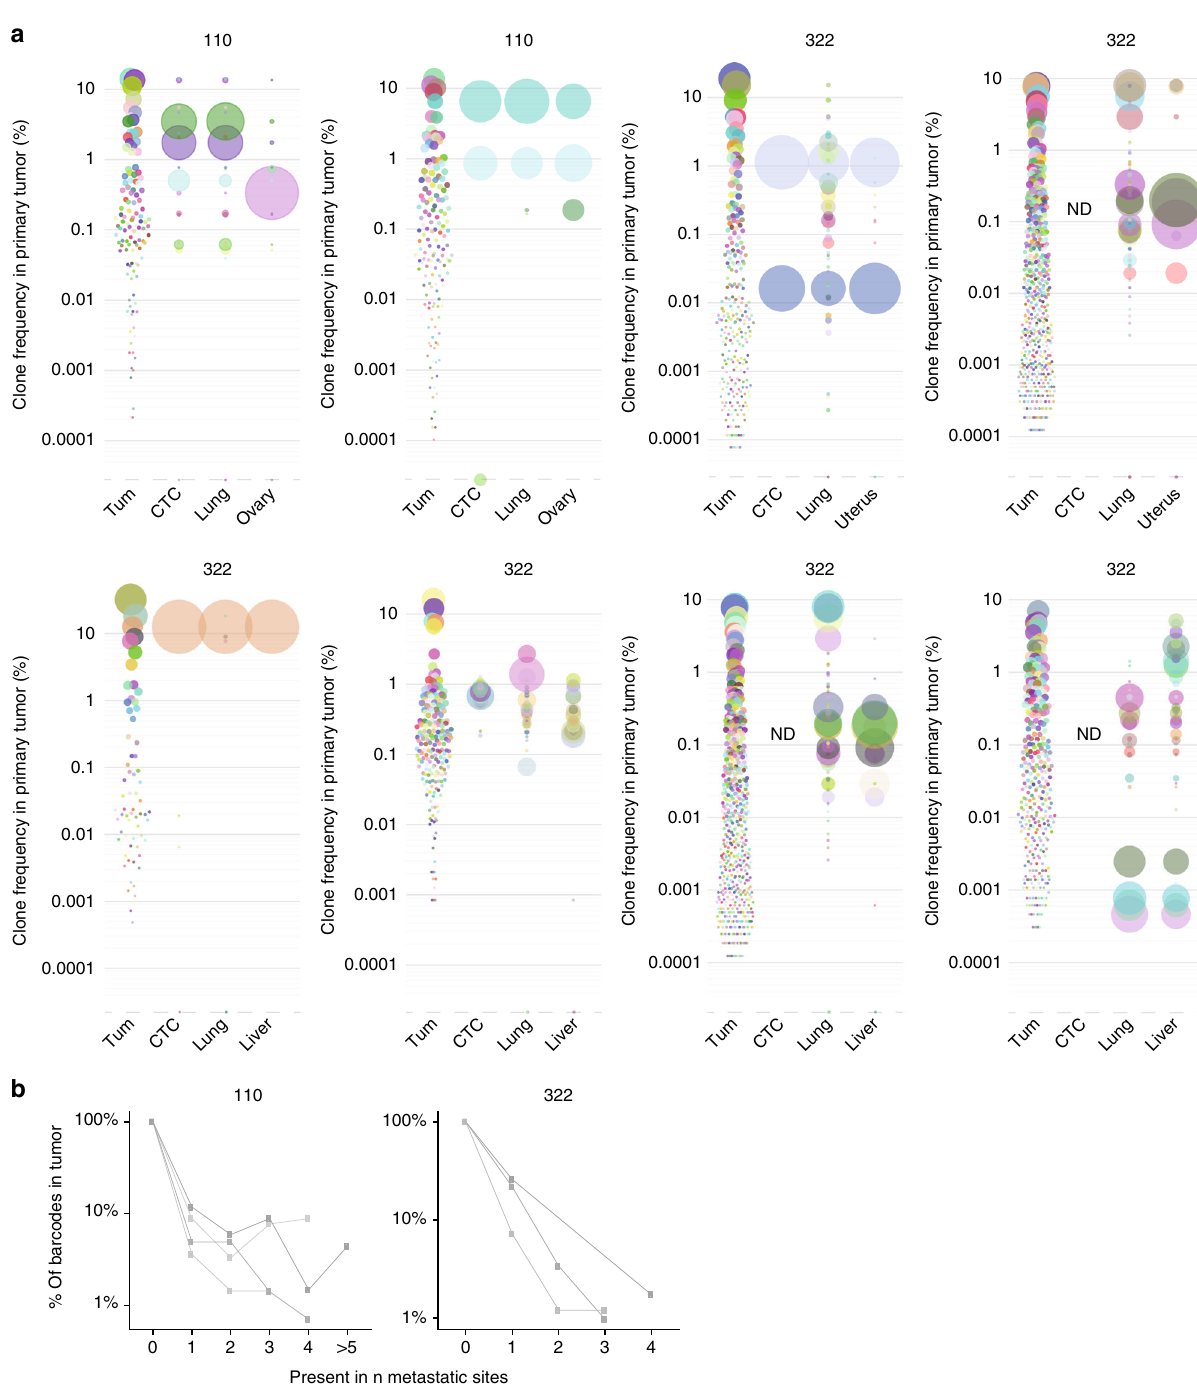
Fig. 5 Properties of multi-organ metastases. a Individual mouse examples of clonal relationships between indicated organs from PDX-110 and -322. Each barcode is indicated by a color for individual mice. The color codes are not conserved between different mice. b Number of clones that are found in none (i.e. in tumor only) or one or more metastatic sites for 4 (PDX-110) or 3 (PDX-322) individual mice (each mouse represented by a